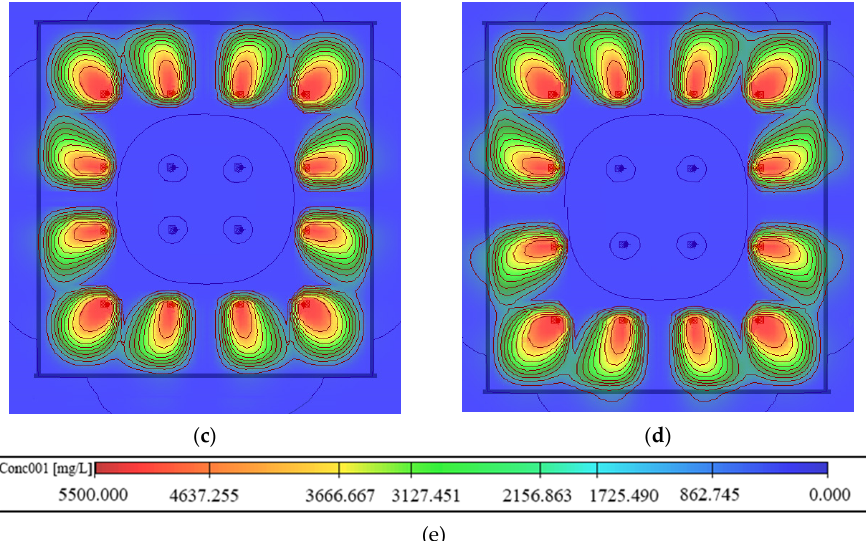
Figure 8. Horizontal migration of S. pasteurii in different time periods: ( a ) 1d; ( b ) 2d; ( c ) 3d; ( d ) 4d; ( e ) Legend.